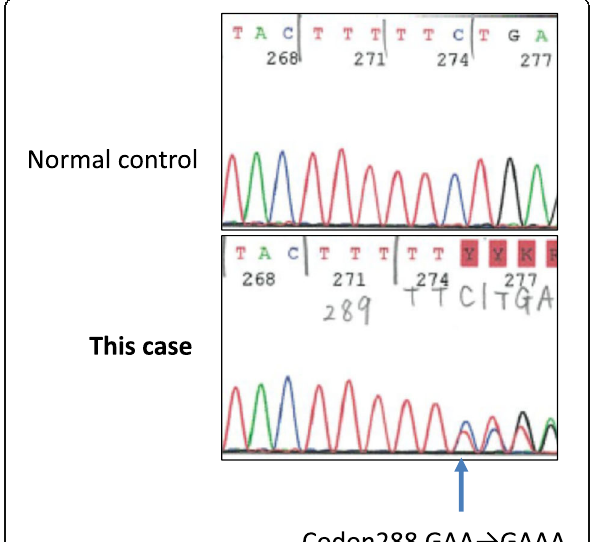
Fig. 2 Analysis of PTEN gene mutations. Genomic DNAs for germ line mutation analyses were obtained from the buffy coat and resected tumor. Polymerase chain reaction products were sequenced directly using an automated DNA-sequencing system (Model 3130; Applied Biosystems, Foster City, CA). PTEN sequencing demonstrated that a germ line mutation c. 288 insertion A was found in exon 8, which caused a frameshift mutation (p.V290fs*8). A reverse primer was